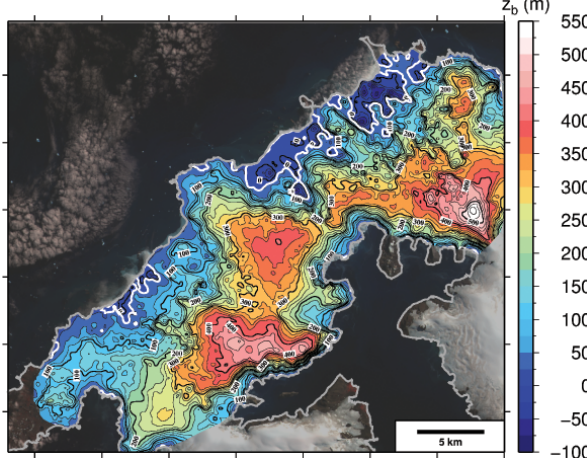
Figure 6. DEM of the calculated bedrock topography z b in m (WGS84 ellipsoidal height) on King George Island (the contour line interval is 25m). The white thick line surrounds areas below sea level (details see main text); the grey thick line shows the coast- line. Database: compilation of the ground based survey (taken from Blindow et al., 2010) and the airborne measurements. Background image is a © SPOT Image from